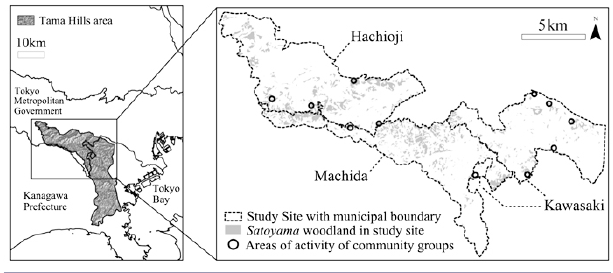
Fig. 1 . Map of surveyed community groups and satoyama woodland in the northern Tama Hills area of Tokyo,